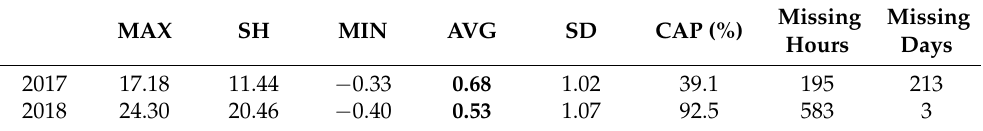
Table 2. Hydrogen sulfide monthly and yearly values measured at air monitor Beaumont Mary